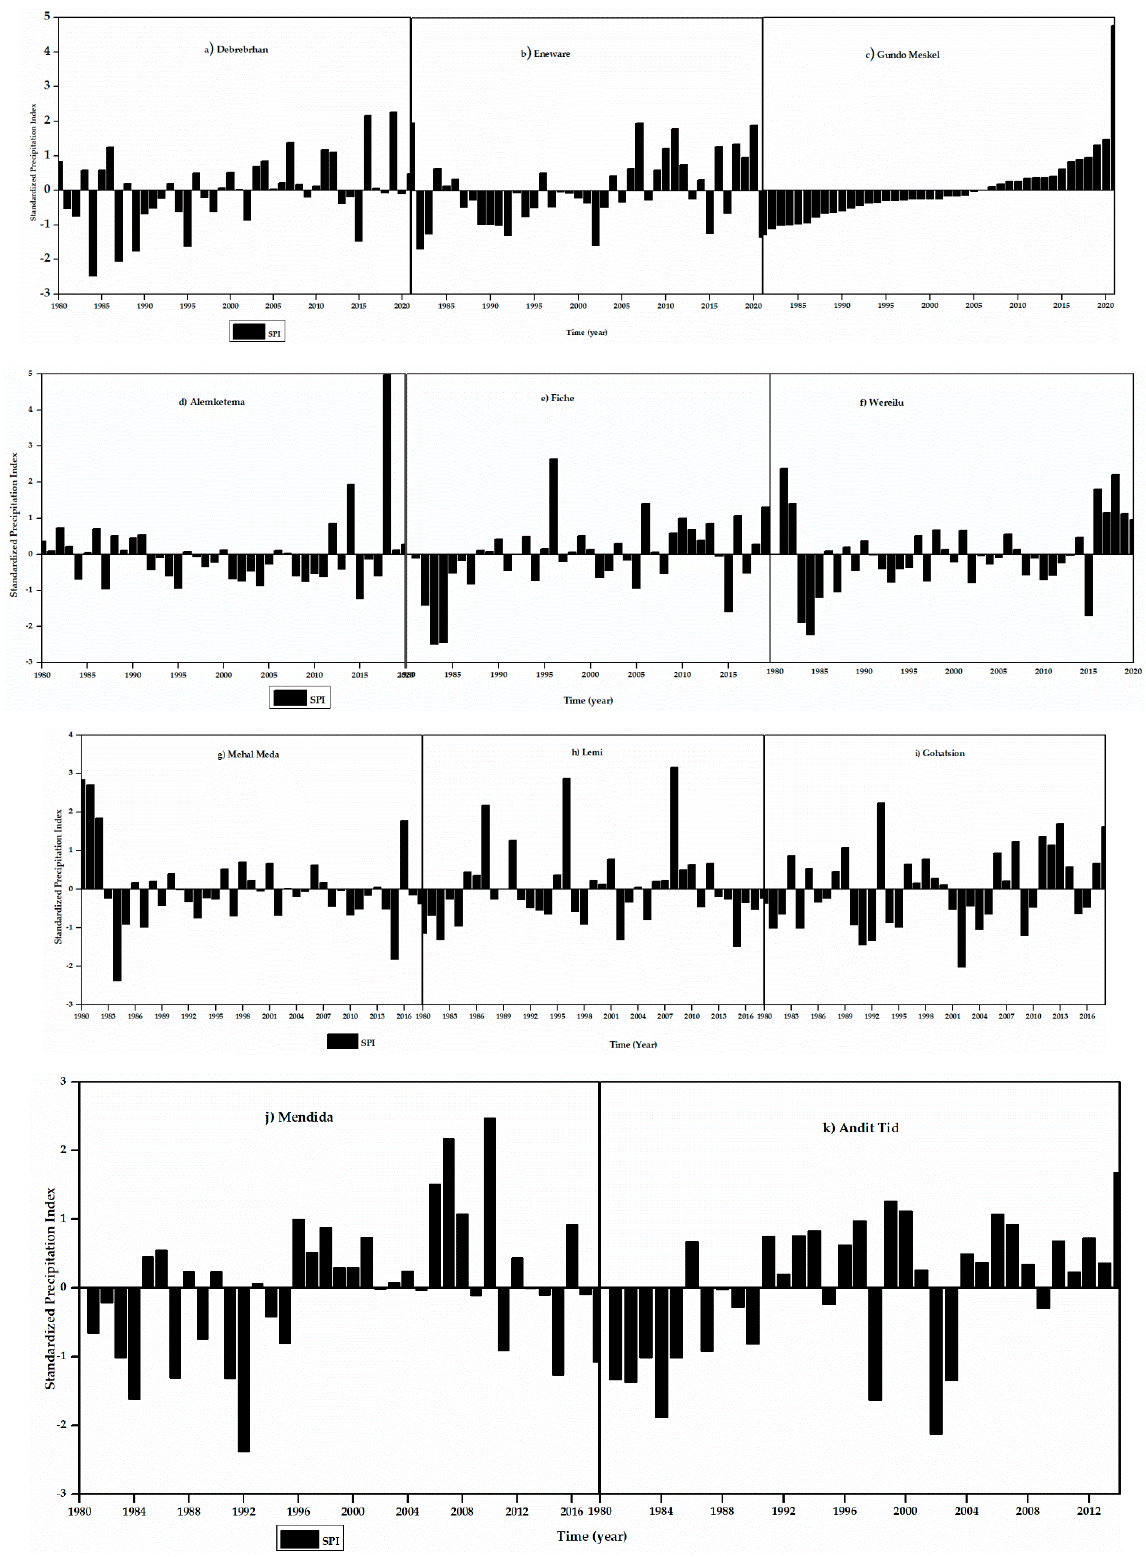
Figure 6. Standardized Precipitation Index of ( a ) Debrebrhan, ( b ) Eneware, ( c ) Gundo Meskel, ( d ) Alemketema, ( e ) Fiche, ( f ) Wereilu, ( g ) Mehal Meda, ( h ) Lemi, ( i ) Gohatsion, ( j ) Mendida, and ( k ) Andit Tid.